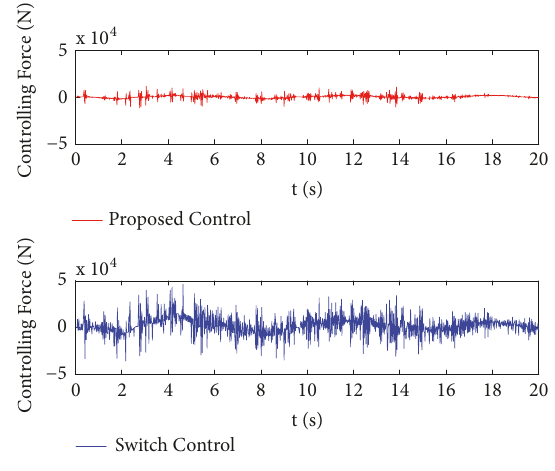
Figure 8: Controlling force of Example 2.